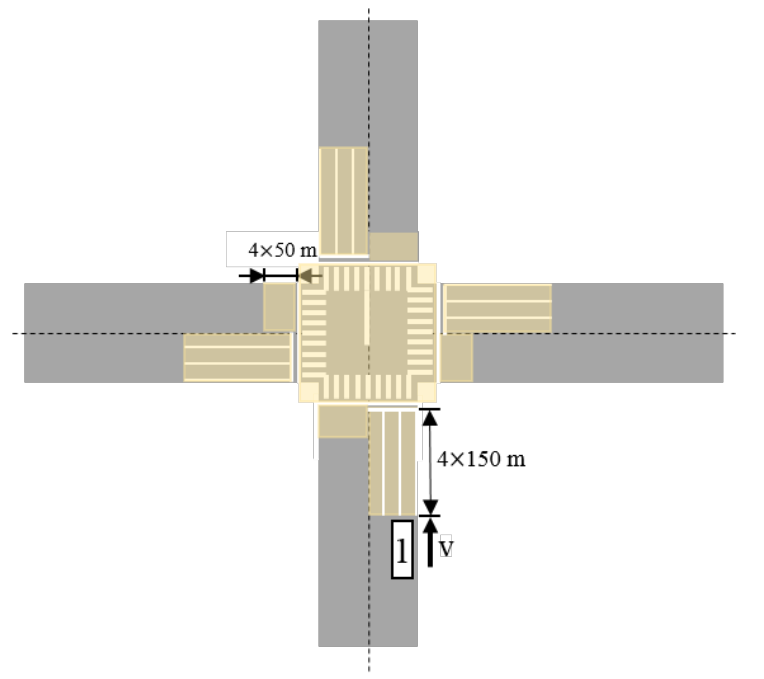
Figure 3. Illustration of the data indicating effective distance at the intersection. The beige area that covers the intersection denotes the effective distance for obtaining data.